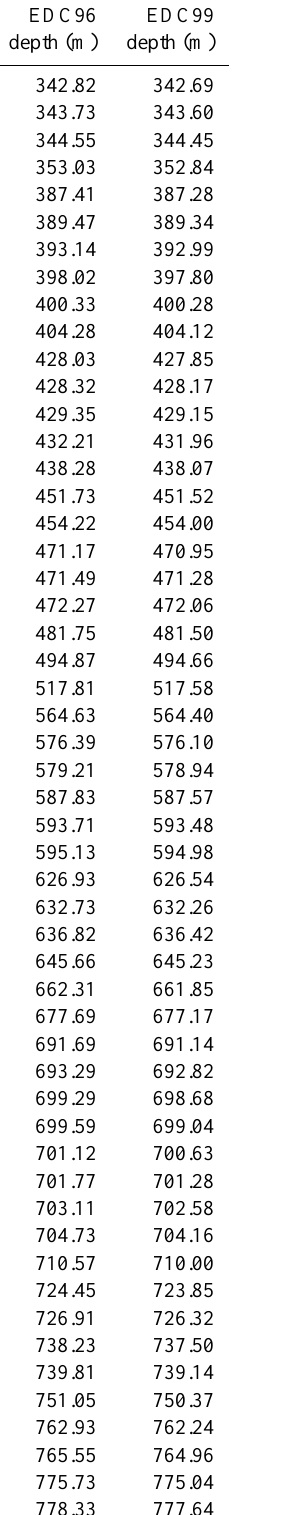
Table 2. List of volcanic tie points between the VK-BH7 and VK- 5G ice cores using the ECM